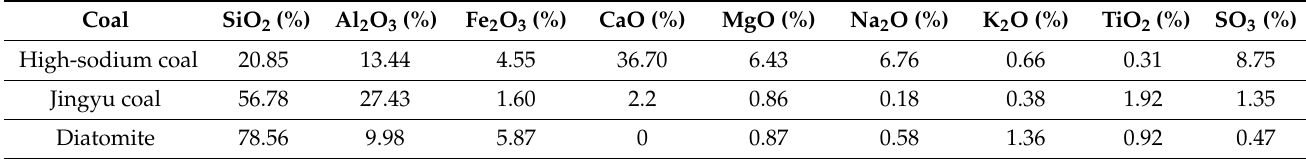
Table 2. Ash composition analysis of raw